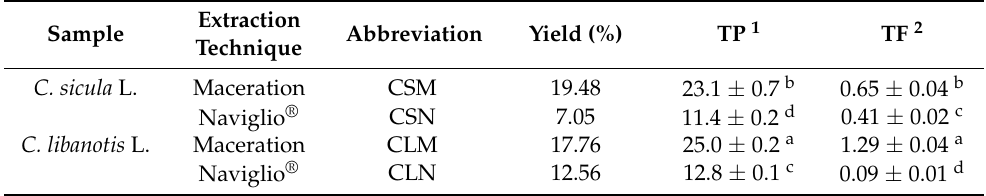
Table 1. Investigated Cachrys species: Yields and total phenolics and flavonoids.